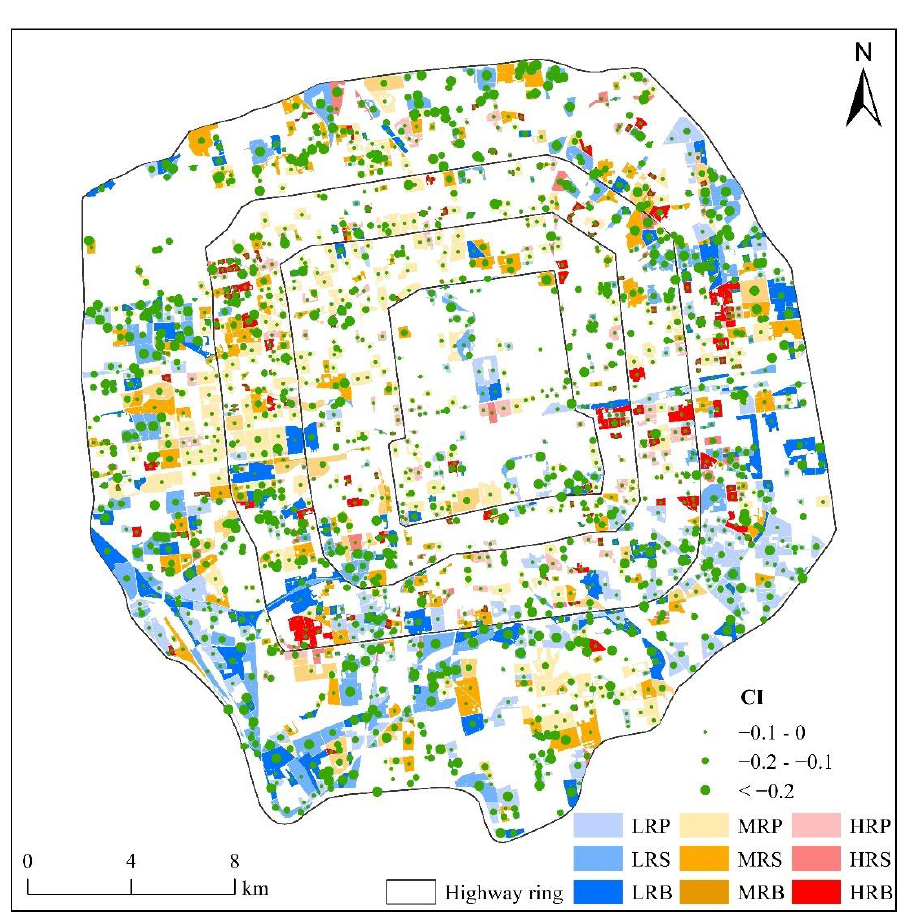
Figure 7. Spatial distribution of CI among different urban blocks.